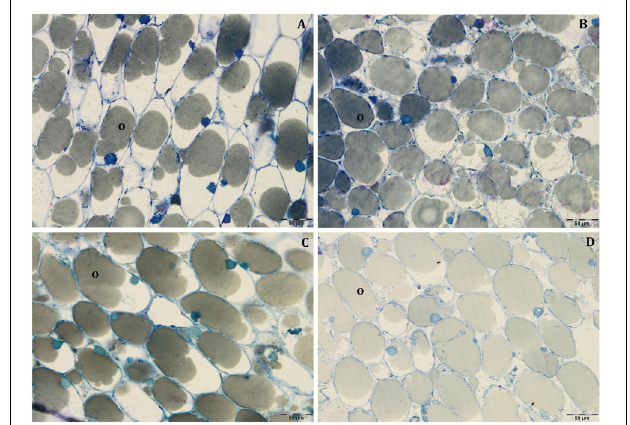
FIGURE 6 | Semi-thin sections at 140 DAF of Leccino (A,C) and Frantoio (B,D) fruits in light (A,B) , and shade (C,D) conditions: the cell volume occupied by the oil drops was higher in Frantoio (B,D) than Leccino (A,C) fruits. All the figures are stained with toluidine blue.